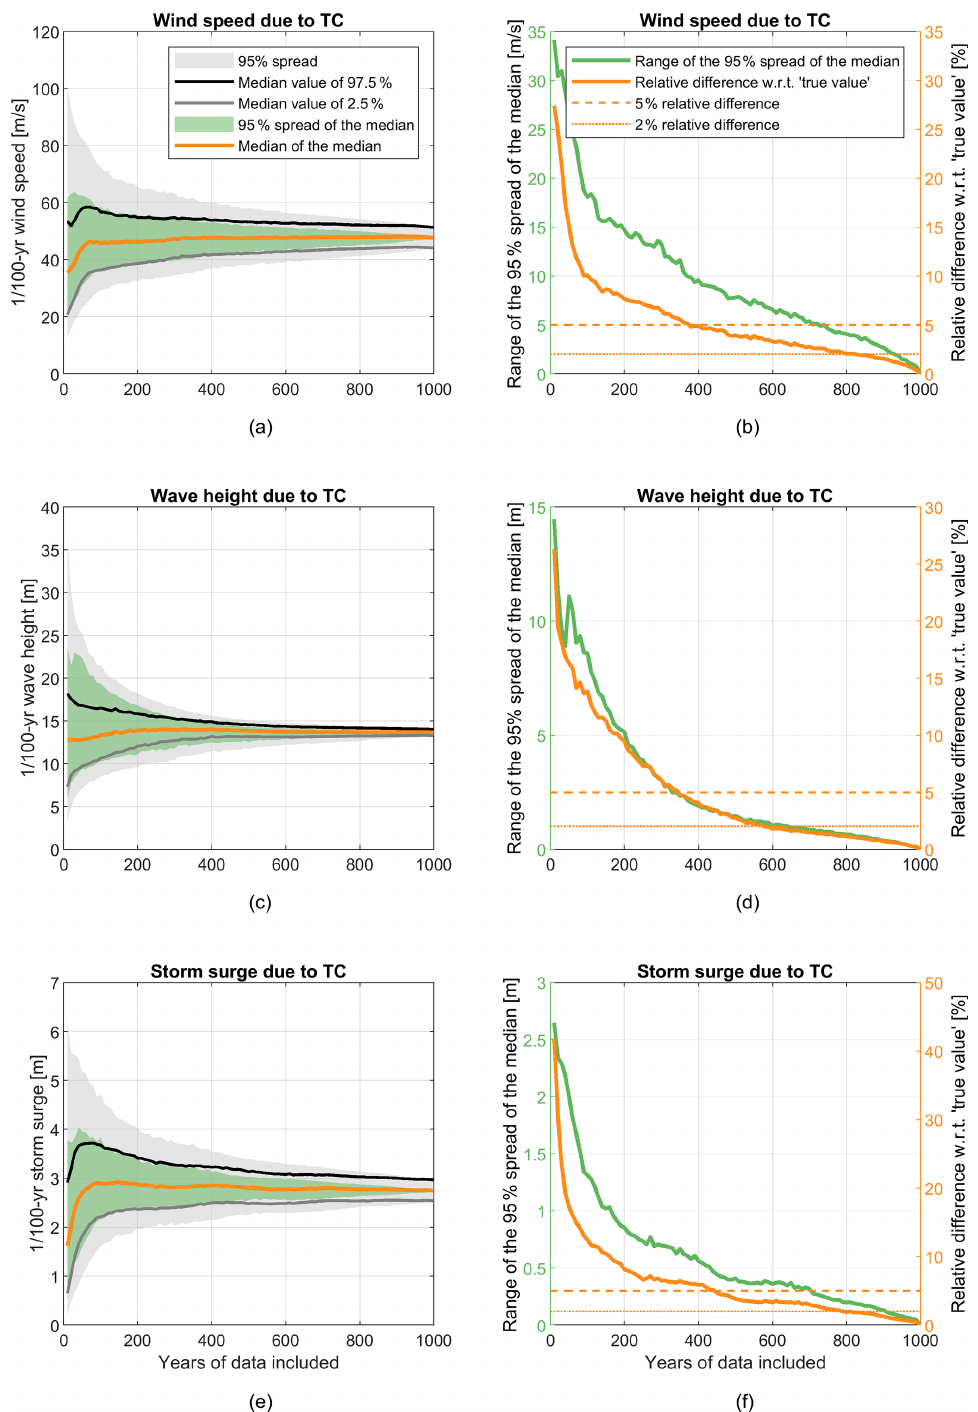
Figure 6. Verification of the convergence of the 100-year return period computed wind speed, wave height and storm surge as a function of the number of years of STCC tracks included in the analysis. Panels (a) , (c) and (e) refer to wind speed, wave height and storm surge, respectively. The 95% spread (97.5th − 2.5th percentile) is indicated by the gray fill; the median value of the 97.5th percentile is shown as a black line, and the median value of the 2.5th percentile is shown as a gray line. The green fill shows the 95% spread of the median values, while the orange line indicates the median of the median value. Panels (b) , (d) and (f) show the range of the 95% spread of the median value (green line) and the relative difference with respect to the true value, which is the estimate based on 1000 years of STCC tracks (orange line) for wind speed, wave height and storm surge,